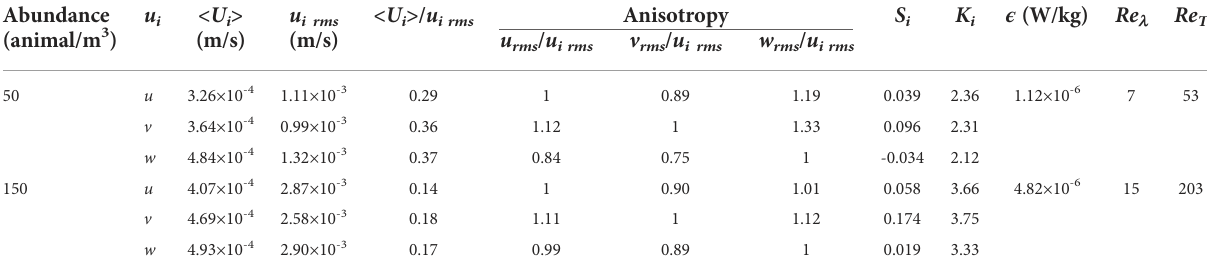
TABLE 1 Comparison of the statistics measured in the x, y and z directions of the aquarium at different pangasius abundances. Abundance (animal/m 3 )